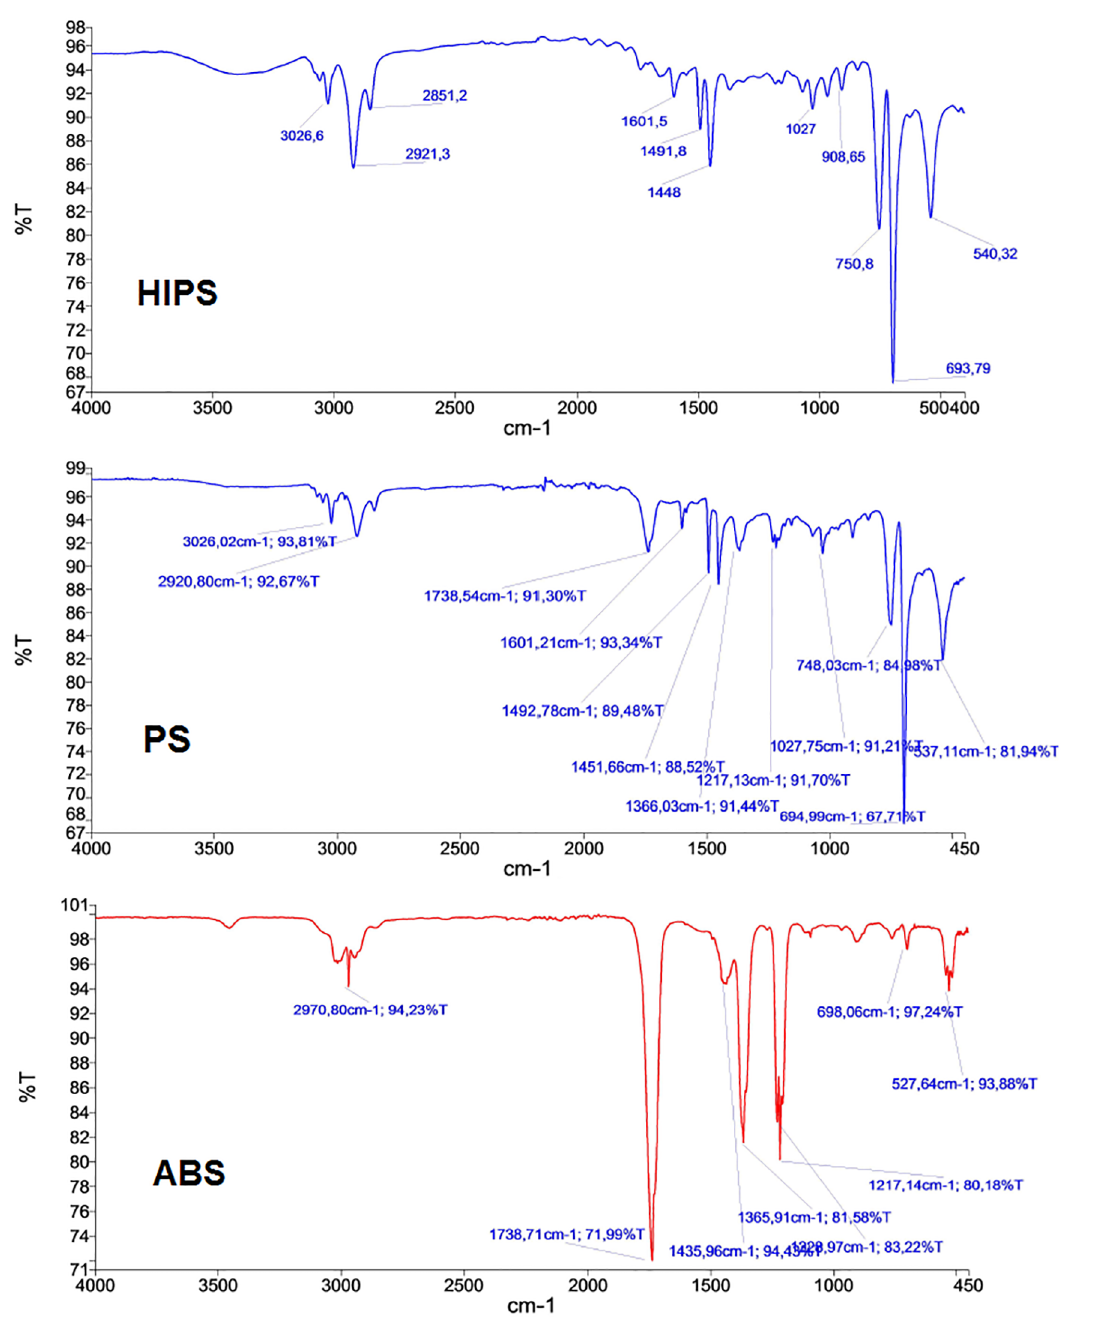
Figure 2. Spectrums graphs of HIPS-100%, ABS-100% and PS-100%.